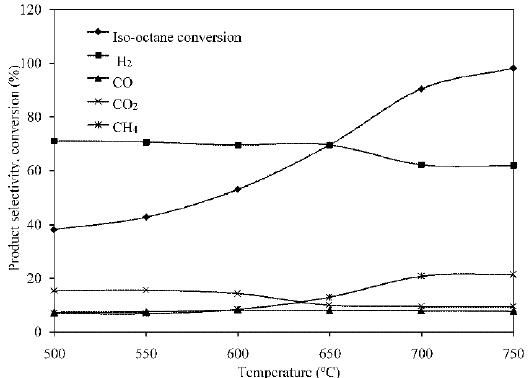
Figure 9. Effect of temperature on conversion and product selectivity over 18 wt. % Ni 0.5 ‐ Cu 0.5 / γ‐ Al 2 O 3 catalyst, N 2 = 15 cm 3 /min; iso ‐ octane feed rate was 0.03 g/min; S/C molar ratio: 0.9.